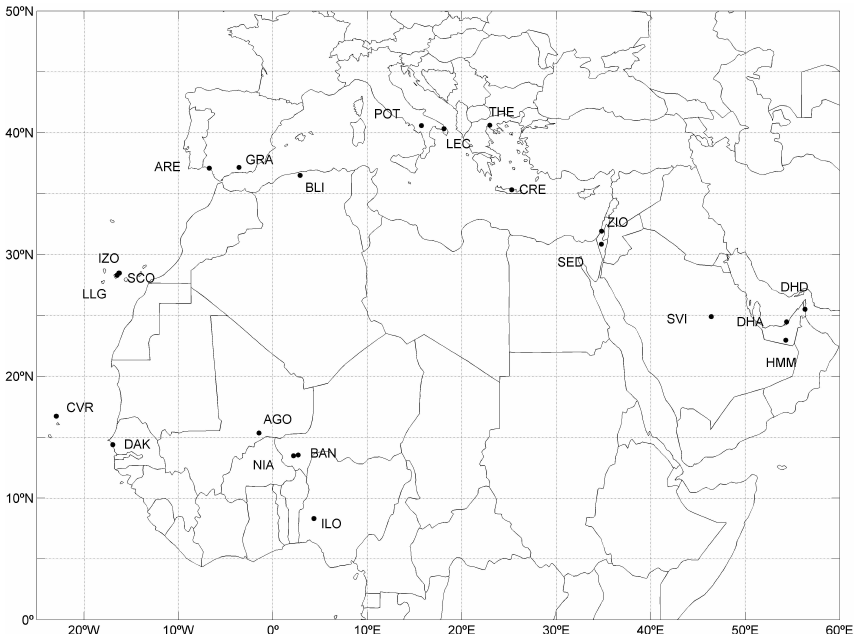
Fig. 3. Location of the AERONET stations used in the regional evaluation. The map includes the acronyms of the stations defined in Table 3.